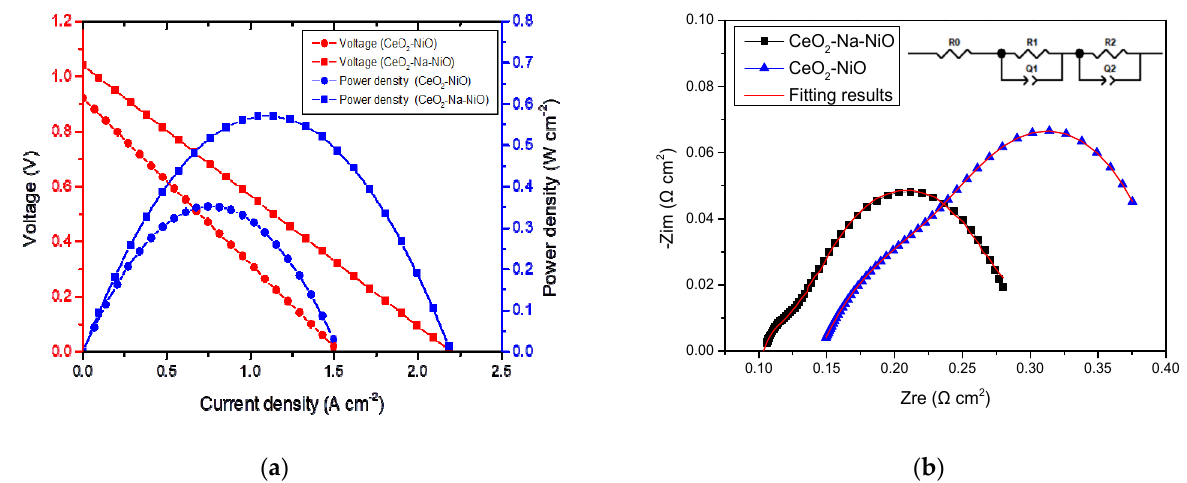
Figure 5. ( a ) Electrochemical performance of the fuel cells with CeO 2 -NiO and CeO 2 -Na-NiO at 530 °C; ( b ) EIS of Figure 2. NiO and CeO 2 -Na-NiO at 530 °C.